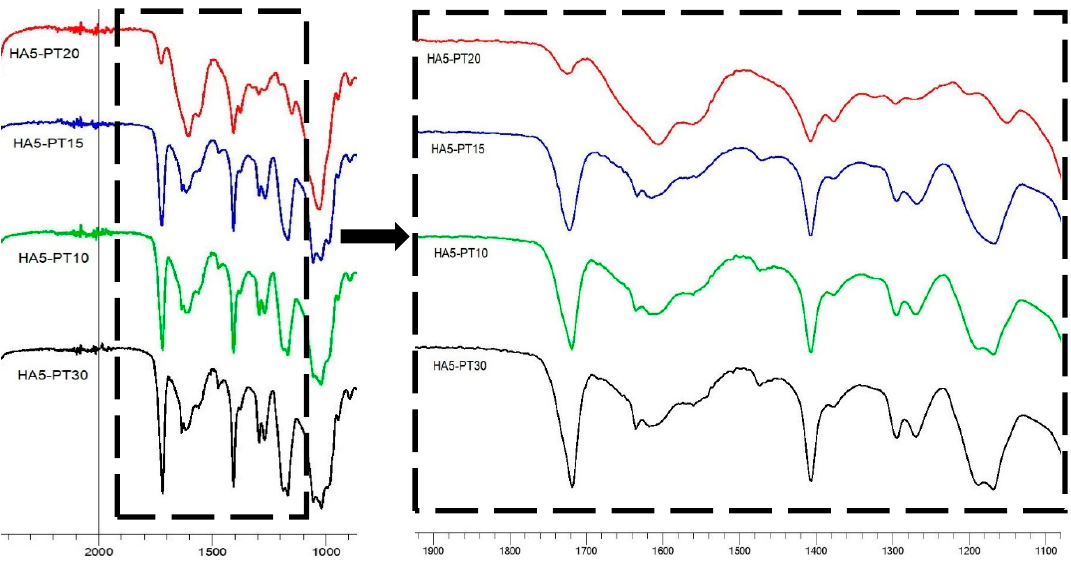
Figure 12. HA5-PT30 crosslinked by oven-assisted thermal method (x-axis is the wavenumber/cm − 1 ).